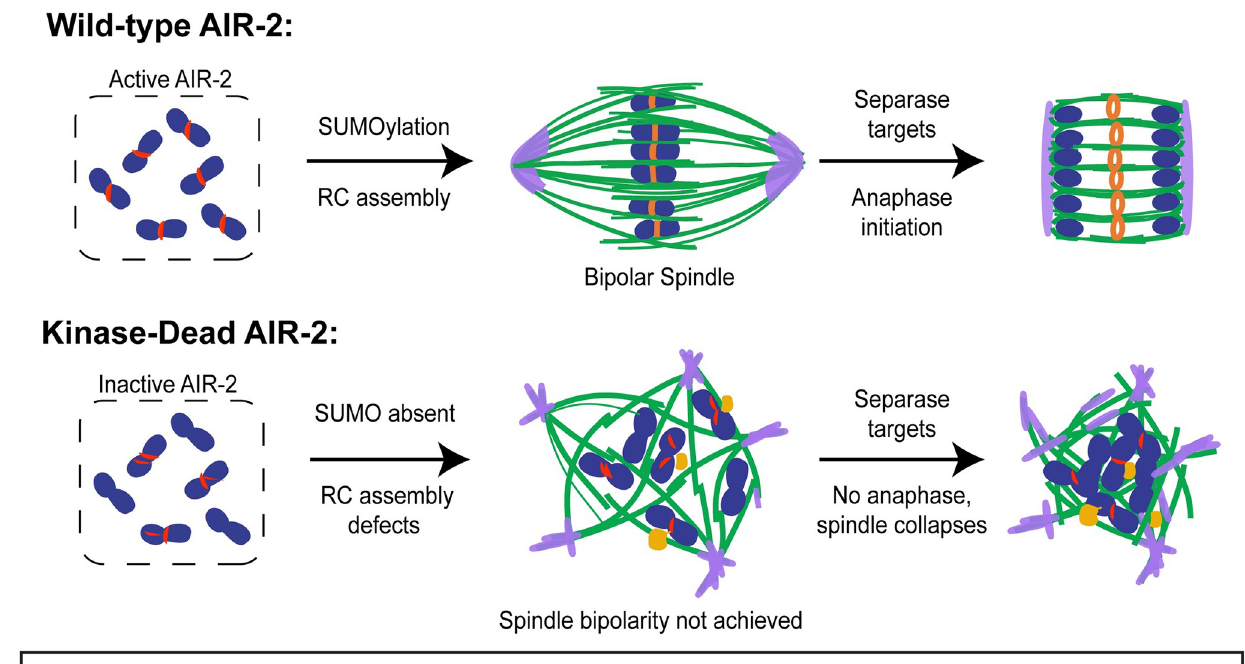
Fig 7. Model. Model depicting spindle assembly and chromosome segregation in wild-type oocytes (top) compared to oocytes lacking AIR-2 kinase activity (bottom). In wild-type oocytes, AIR-2 (red) localizes to the midbivalent, the RC forms and is SUMOylated (orange), and bipolar spindles form with ASPM- 1 (purple) at the two poles. Chromosomes then separate and the RCs are left behind in the spindle midzone. In contrast, in the absence of kinase activity, AIR-2 is mispatterned on chromosomes, the RC is not SUMOylated, and SUMO (yellow) forms accumulations that are not chromosome-associated. Moreover, spindles do not achieve bipolarity and chromosome segregation